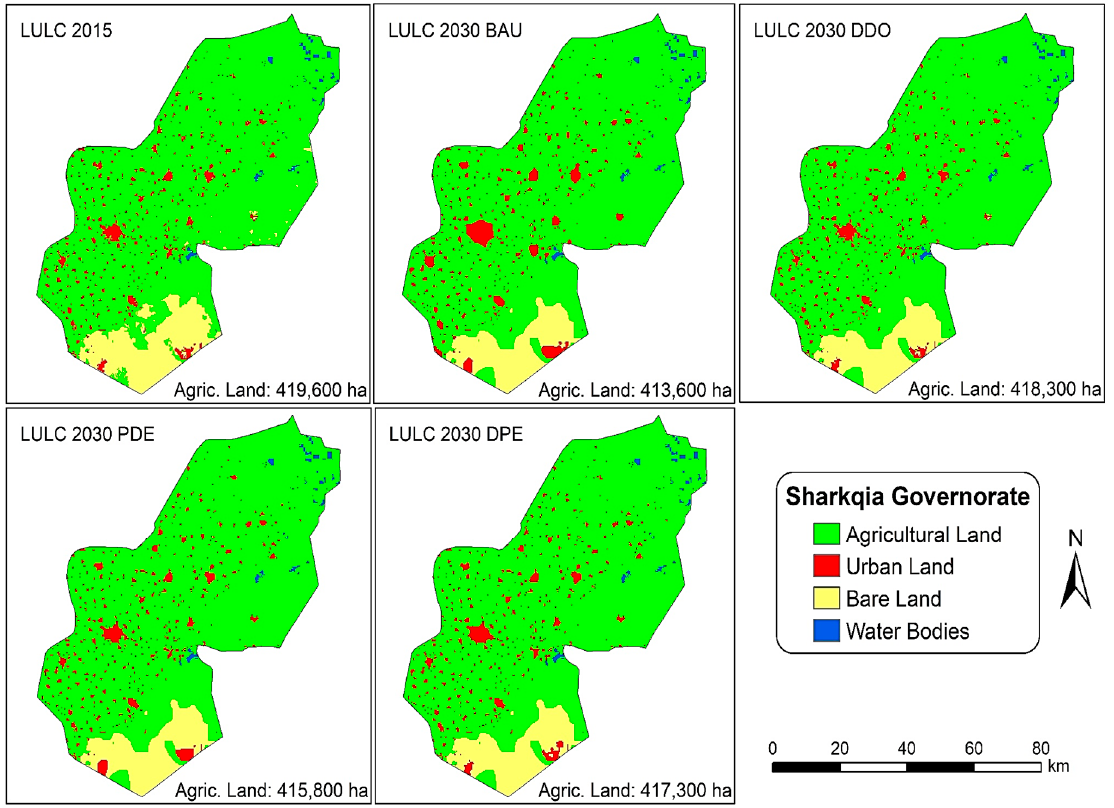
Figure A7. Amount of agricultural land over Sharkqia governorate within the simulated scenarios relative to state in 2015.